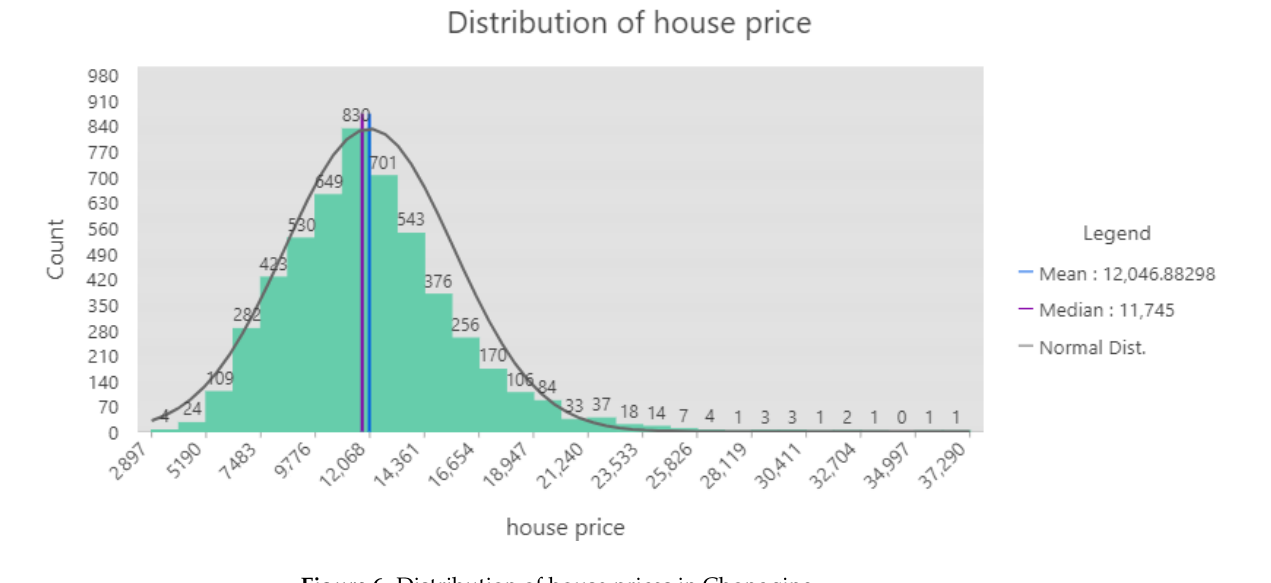
Figure 6. Distribution of house prices in Chongqing.